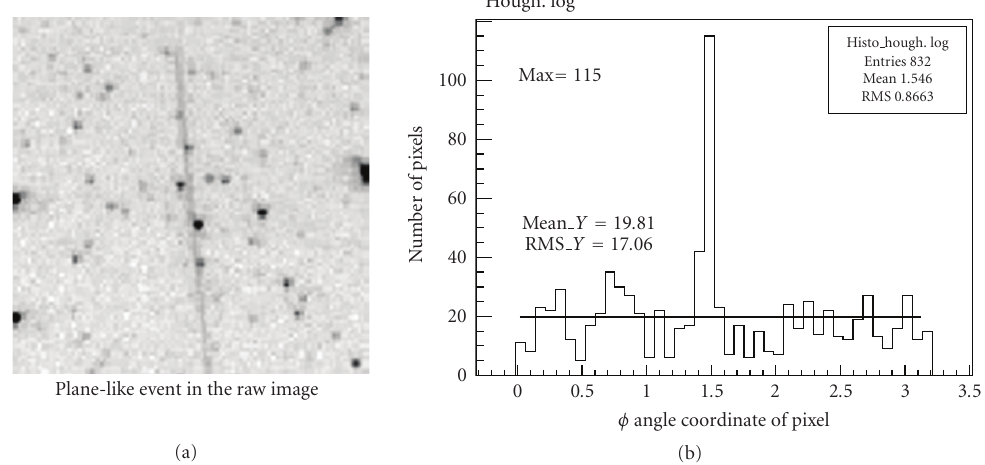
Figure 6: The original image of the event (a) and the distribution of the φ angle coordinate for the plane-like event (b).